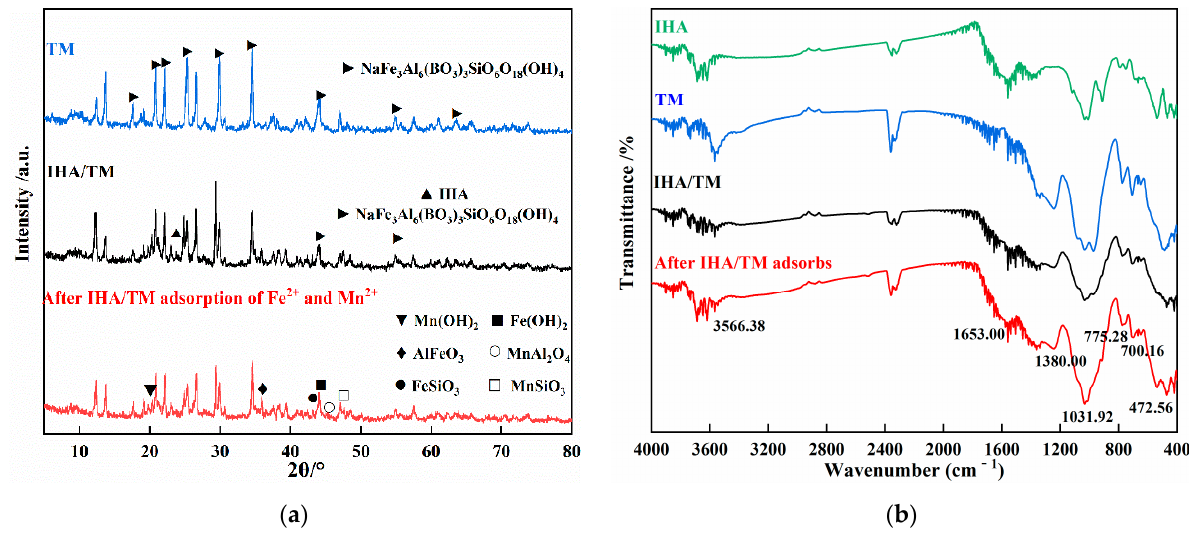
Figure 9. XRD pattern of IHA/TM before and after adsorption ( a ); FTIR spectra of IHA/TM before and after adsorption ( b